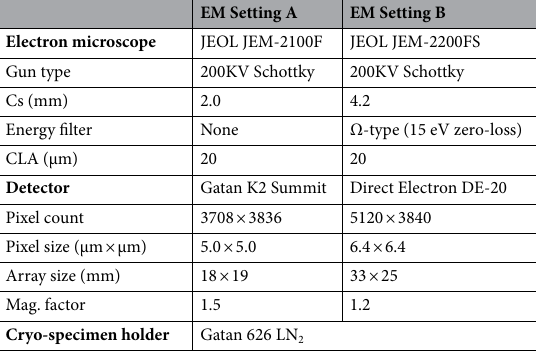
Table 2. Details of TEM Settings A and B.